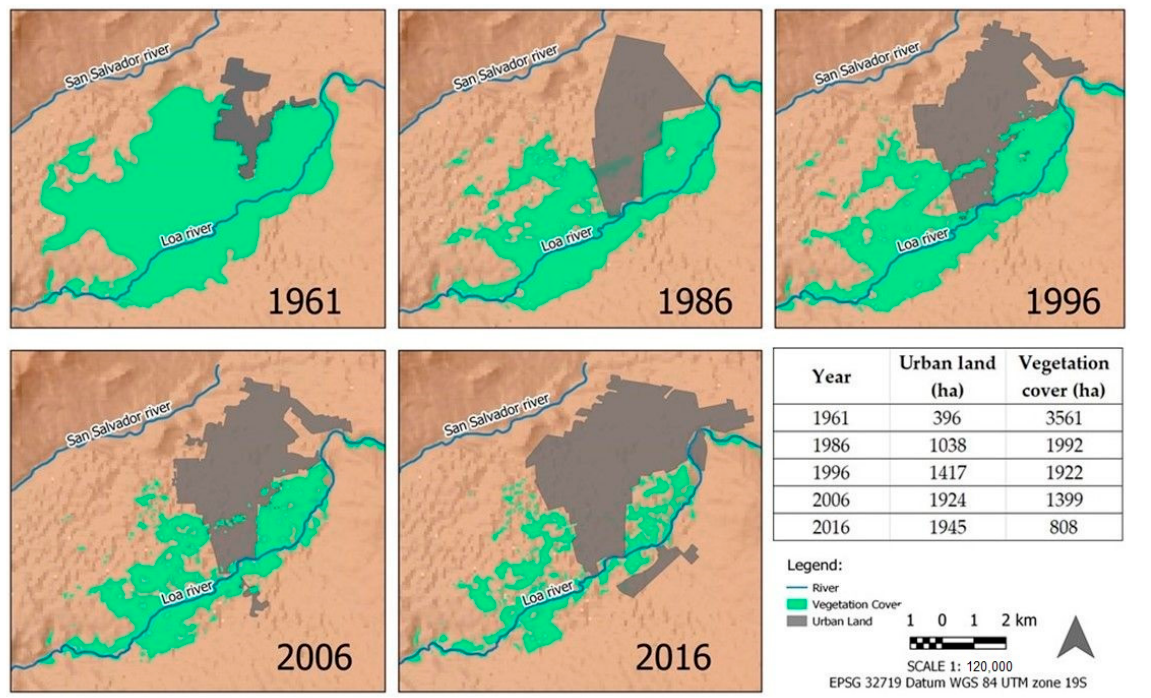
Figure 6. Evolution of urban land and vegetation cover in the Calama oasis (1961–2016). During the ethnographic work conducted, researchers recorded that there are still some smallholder family farms operating in the Calama oasis today that grow alfalfa and corn (for family use and sale) and raise livestock (for family use and occasional sale). Sheep are the main livestock, although there are also goats, llamas, some horses, and smaller animals (pigs and rabbits) present. Families provide the labor for all of these agricultural and livestock activities. In regard to livestock, the vegas are no longer used for grazing; animals are instead rotated among corrals. This is because of the limited workforce available, the small number of animals, and the poor nutritional quality of vegetation in the vegas. It should be noted that many family members engaging in farming activities do not do so full time, especially the younger generations, who are inclined to seek out salaried work or self-employment in cities (construction, service, retail, etc.) and, to a lesser degree, in industry or mining operations. In fact, for some families living in rural areas, agricultural and livestock activities play a marginal or even nonexistent role in their livelihood. As for the sale of agricultural products, our ethnographic data shows that alfalfa is sold directly from the farms to other peasant farmers in the area of study or those in other rural areas of the Loa interior. Some farmers sell alfalfa to the Calama Rodeo Club. Corn is often sold directly from the farm as well, in small quantities to intermediaries. Occa- sionally, an entire field of corn is sold to a single buyer who will arrive with laborers to harvest the crop. The general perception among interviewees is that agriculture has been diminishing over time and is presently extremely precarious. According to testimonials based on in- terviewee experiences, the following processes have been causing this situation: • Urban sprawl into farmlands and vegas, as well as non-agricultural use of rural spaces, the latter by longstanding property owners who have stopped practicing ag- riculture and new owners who purchased their properties for other purposes (e.g., auto-mechanic shops, parking, tourism).